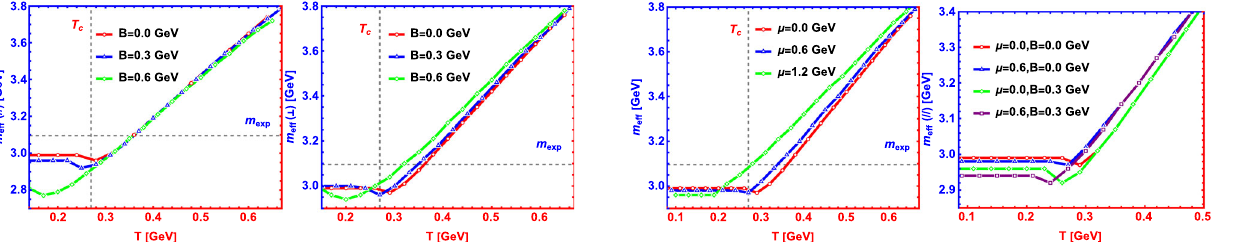
Fig. 4 Left: The effective mass of J /(cid:2) state for different chemical potential μ at B = 0GeV. Right: The effective mass of J /(cid:2) state for thesimultaneouseffectsof B and μ inthecaseofmagneticfieldparallel to